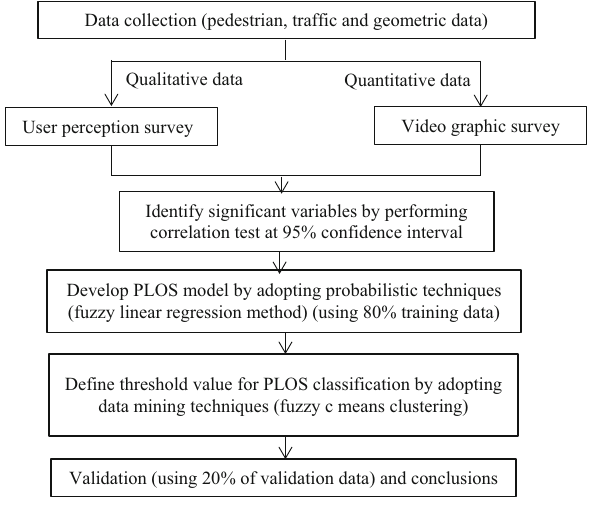
Fig. 1 Major steps involved in PLOS model